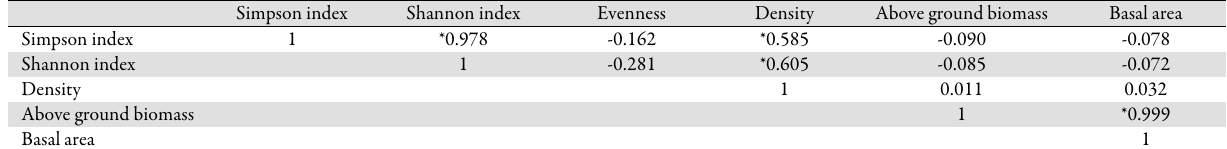
* Indicates significant; marked correlations are significant at p < 0.05 (N =